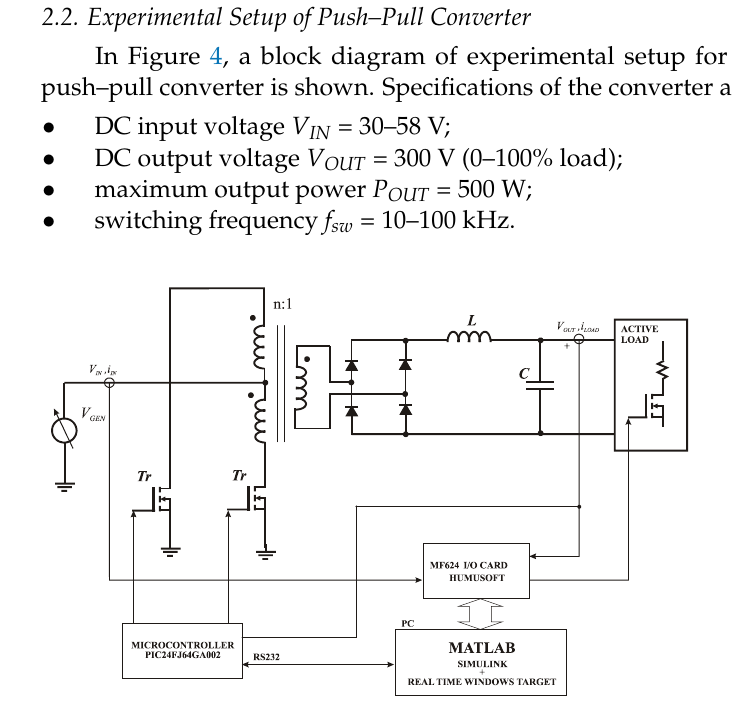
Figure 4. Block diagram of push–pull converter experimental